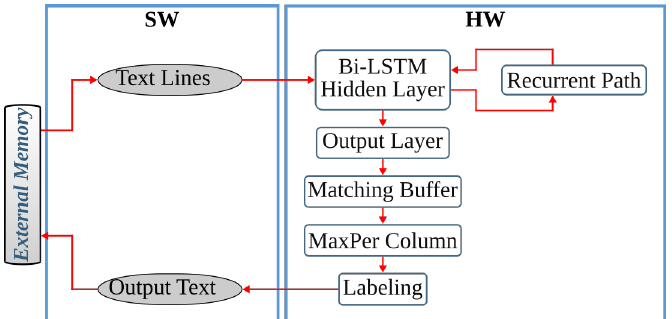
Figure 23. The system-level architecture of the i DocChip text line recognition